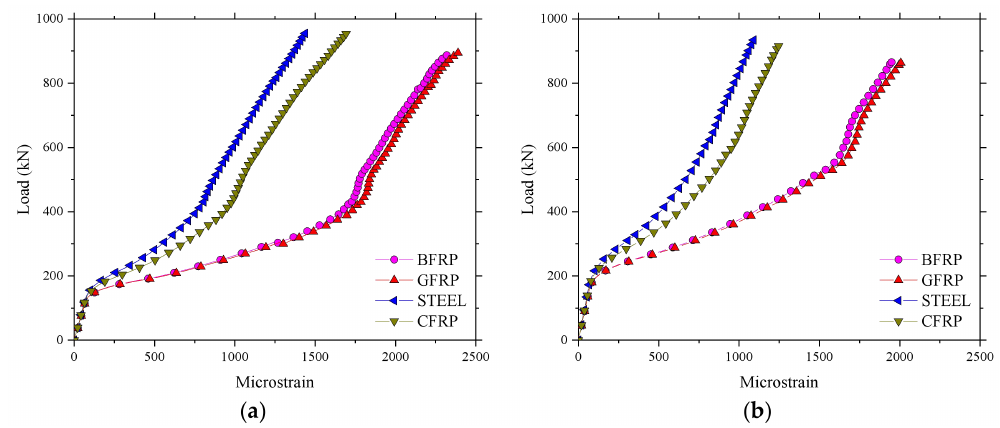
Figure 25. Influence of the reinforcement type on the strain of reinforcement. ( a ) Loading between the W-beams; ( b ) Loading between W-beams and W-beams.